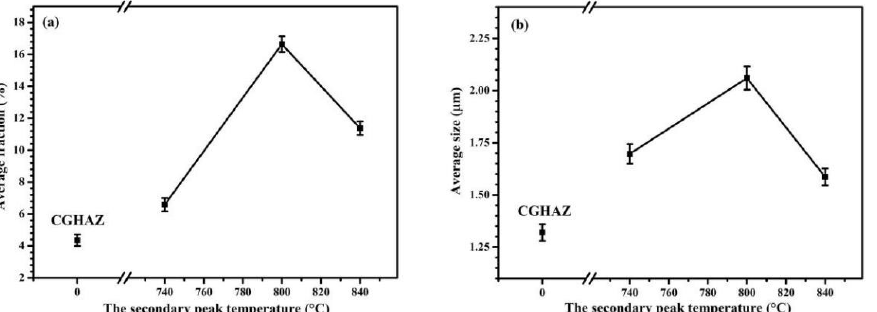
Figure 4. Fraction ( a ) and size ( b ) of M/A constituents in the simulated CGHAZ and ICCGHAZs with different secondary peak temperatures. Figure 3. Microstructure and M/A constituents of the simulated CGHAZ and ICCGHAZs with dif- ferent secondary peak temperatures: ( a , b ) CGHAZ; ( c , d ) ICCGHAZ-1; ( e , f ) ICCGHAZ-2; ( g , h ) IC- CGHAZ-3.